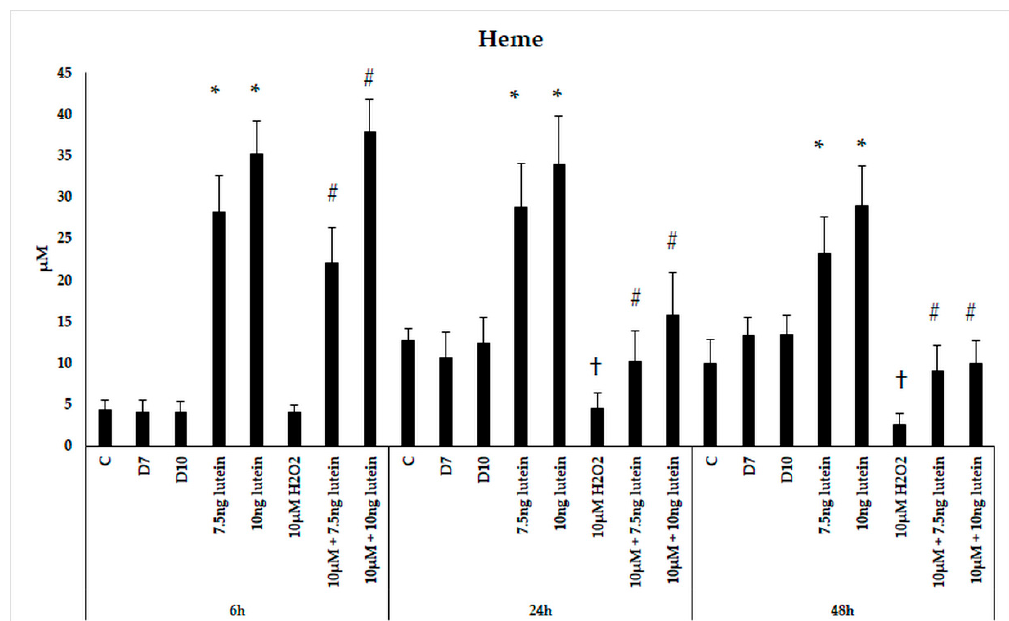
Figure 6. Determinations of heme concentration in lutein and H 2 O 2 -treated BV-2 cells. The columns represent the mean values and error bars indicate the standard deviation (SD) of four independent experiments ( n = 4), each performed in triplicate, and are presented relative to own control cells. * indicates statistical significance of lutein treatments versus controls; † indicates statistical significance of H 2 O 2 -treated cells compared to controls; # indicates statistical significance of combined (lutein with H 2 O 2 ) treatments compared to H 2 O 2 treatments; the level of significance was p < 0.05. Abbreviations: C marks the appropriate absolute controls at 6, 24 and 48 h; D7 means the same amount of DMSO as 7.5 ng/µL of lutein was added; D10 means the same amount of DMSO as 10 ng/µL of lutein was used in the treatments.